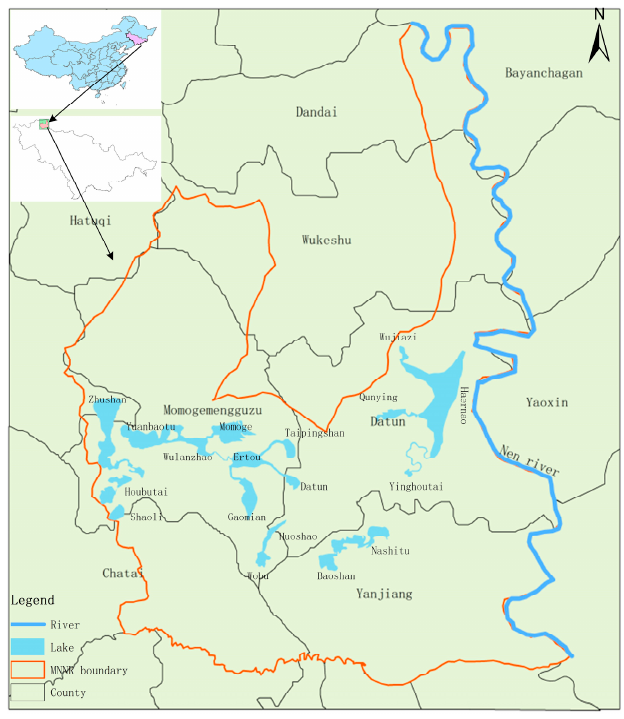
Figure 1. Map of Momoge National Nature Reserve (MNNR).